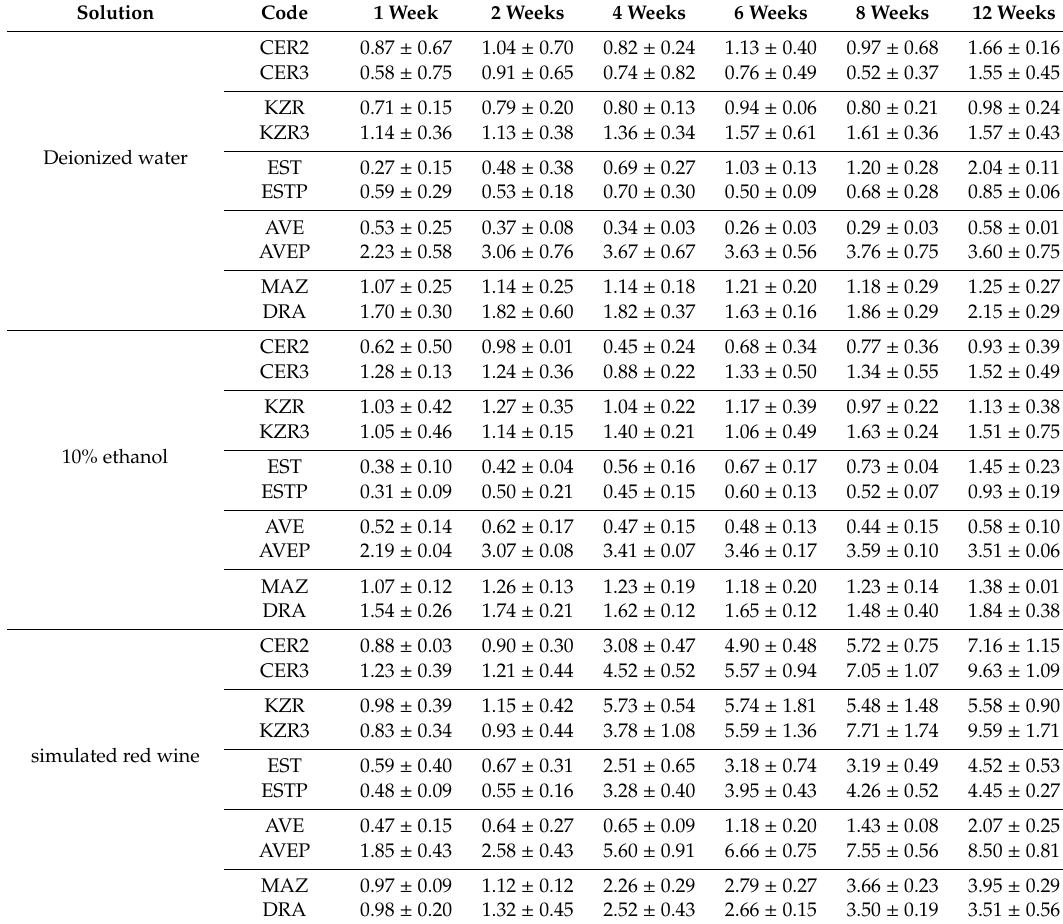
Table 2. Color change ( ∆ E) of samples as a function of immersion periods in 3 di ff erent solutions. Solution Code 1